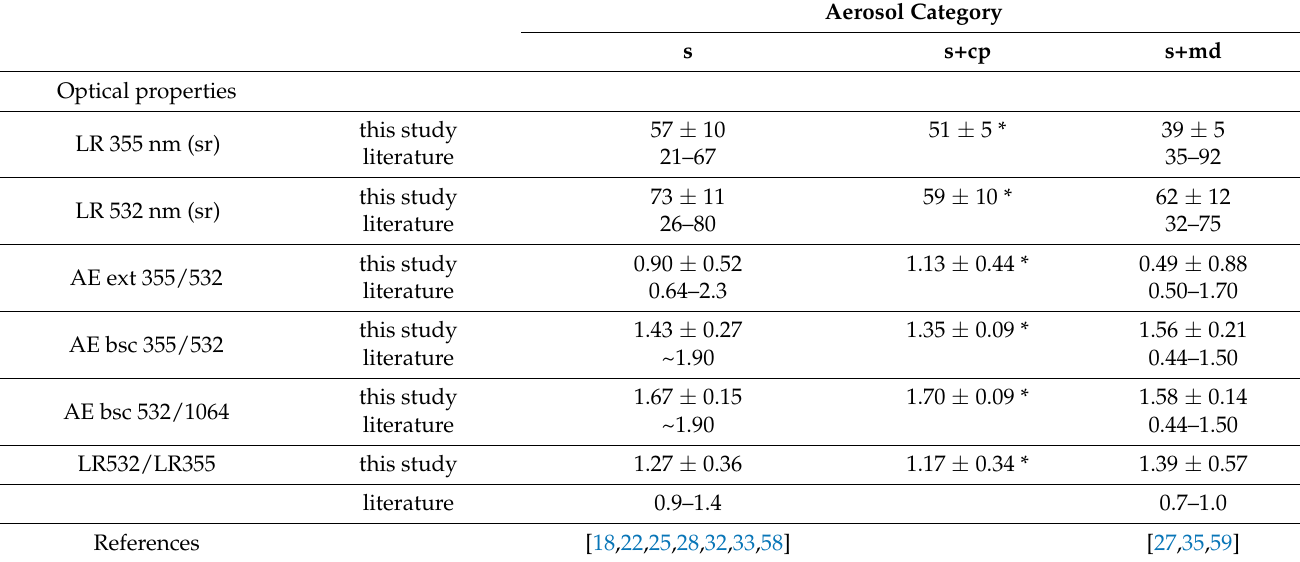
Table 1. Mean values along with their standard deviation of s, s+cp, and s+md aerosol categories for aerosol optical and microphysical properties presented in this study.